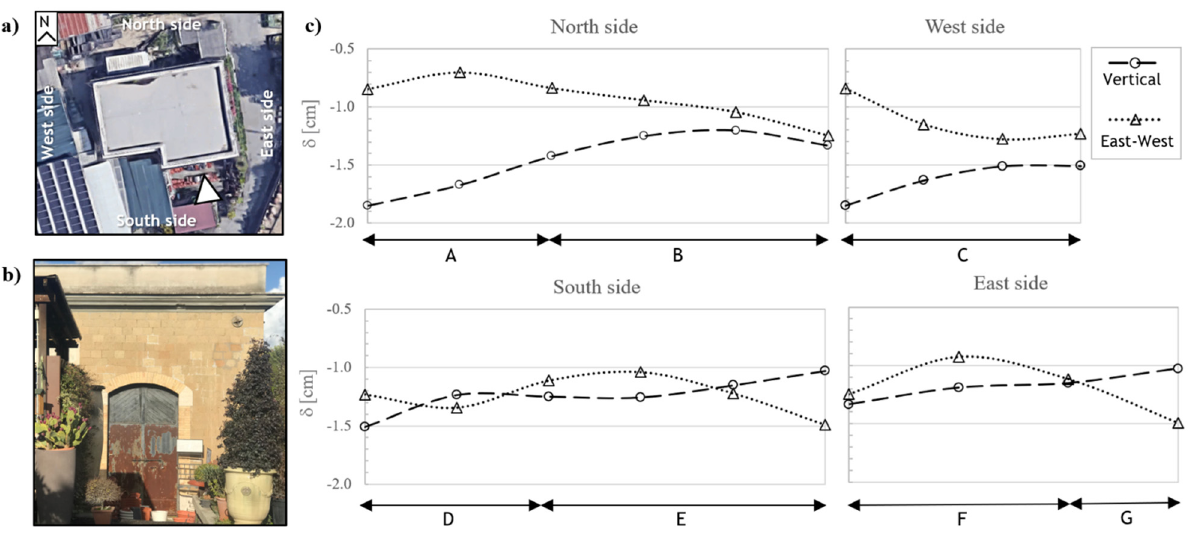
Figure 13. Collector sewer point of disposal n. 7 : ( a ) plan view; ( b ) picture of southern side; ( c ) settlement profiles along the four building sides.